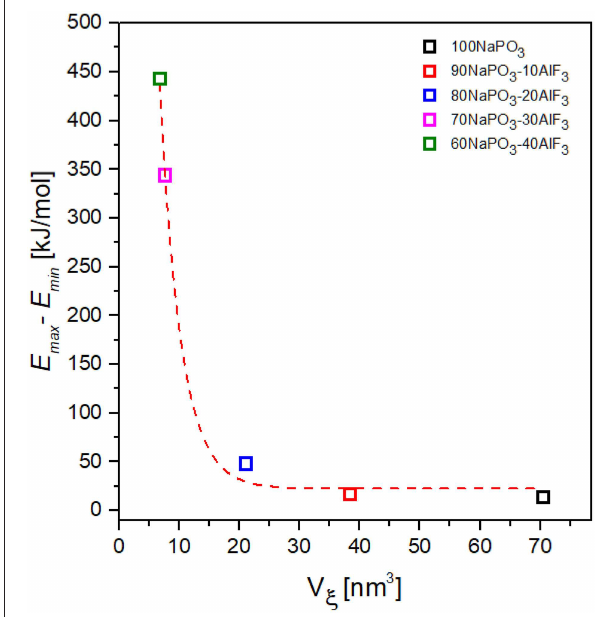
FIGURE 13 | Dependence of the activation energy variability on CRR volume for NAPF [(100- x )NaPO 3 – x AlF 3 , x = 0, 10, 20, 30, 40] glasses.